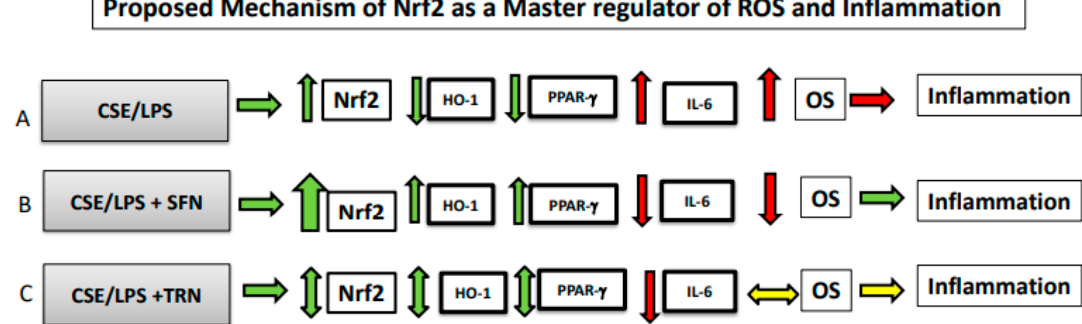
Figure 5. Summary of data: A balanced oxidative stress (OS) and inflammation work cooperatively during gestation to effectively remodel tissues and maintain pregnancy. Sterile (non-infectious) and infectious risk factors can override this balanced activity and cause increased OS and inflammation to cause adverse pregnancy outcomes such as PTB or pPROM. ↓ , down regulation; ↑ , upregulation; ↔ , no change. ( A ): Oxidative stress (OS) inducer CSE and LPS can increase or do not change Nrf2 expression in fetal membranes. Stimulations; however, result in decreased antioxidant HO-1 and anti-inflammatory PPAR γ levels and an increase in IL-6. In summary, CSE and LPS increases OS and inflammation in fetal membranes. ( B ). Co-treatment with sulforaphane (SFN) leads to a substantial increase in Nrf2 (thick up arrow) and subsequent increase in HO-1, PPAR γ and decrease in IL-6 suggesting an overall decrease in OS leading to inflammation in fetal membranes. ( C ). Co-treatment with TRN leads to no change in Nrf2, HO-1, PPAR γ and IL-6 suggesting that no impact on overall OS and inflammation (yellow arrow) in fetal membranes. This model depicts changes observed in this study, and it may not indicate a linear relationship between tested markers in response to stimulants used.